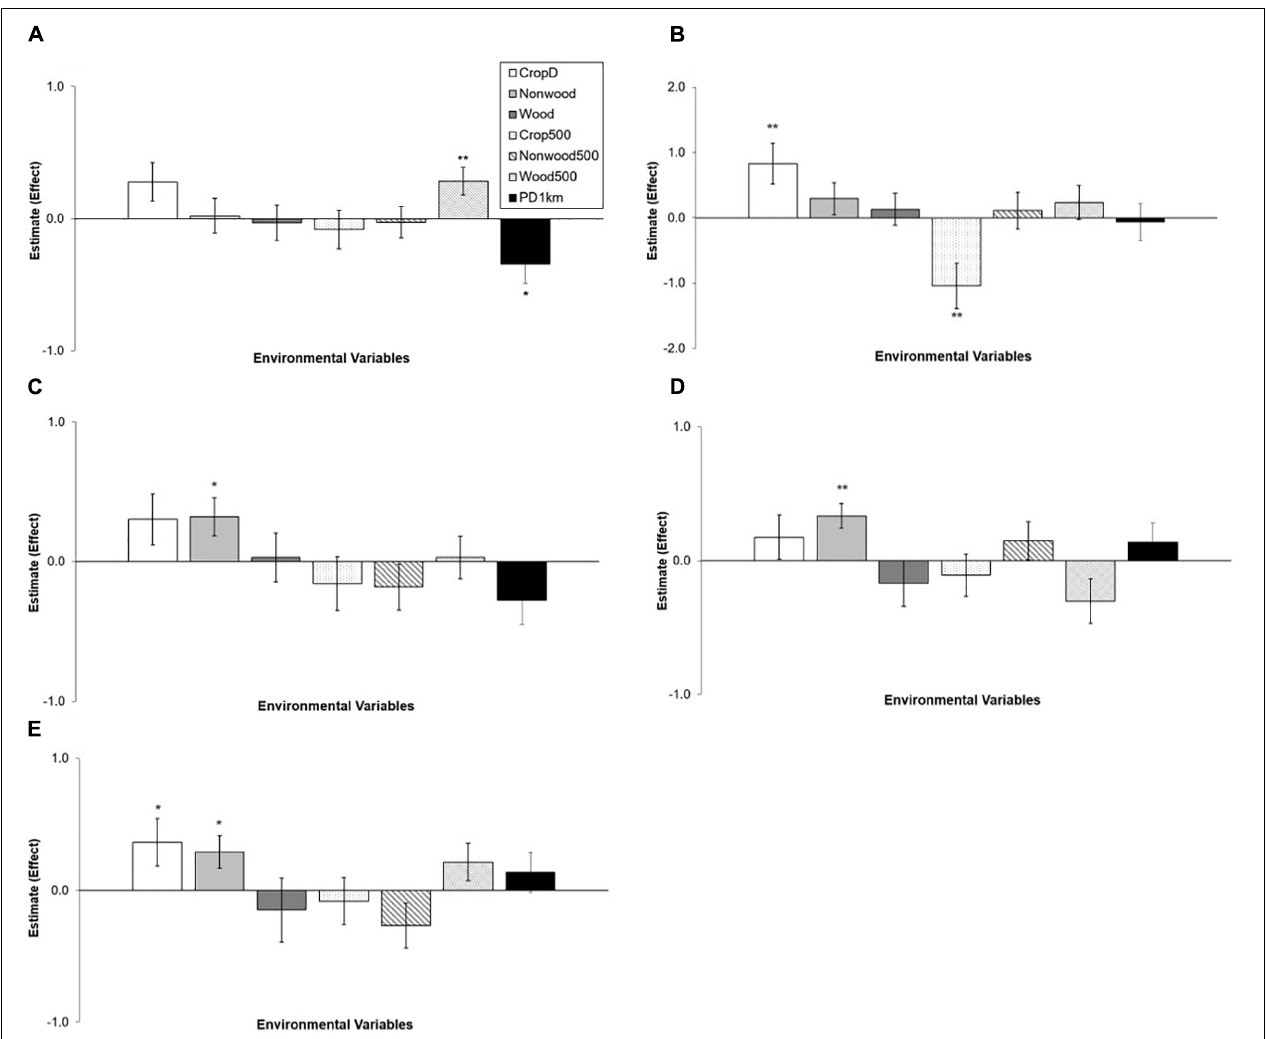
FIGURE 3 | Relationships between environmental variables and abundance of five species: (A) Common Tailorbird, (B) Japanese White-eye, (C) Light-vented Bulbul, (D) Stejneger’s Stonechat, (E) Yellow-bellied Prinia. Estimates are from each of local and landscape models. They are on the log scale and error bars represent standard errors. See the methods for the full name of local (CropD, Non-wood, and Wood) and landscape (Crop500, Non-wood500, Wood500, and PD1km) variables. Significance: *0.01 ≤ P < 0.05; ** P <